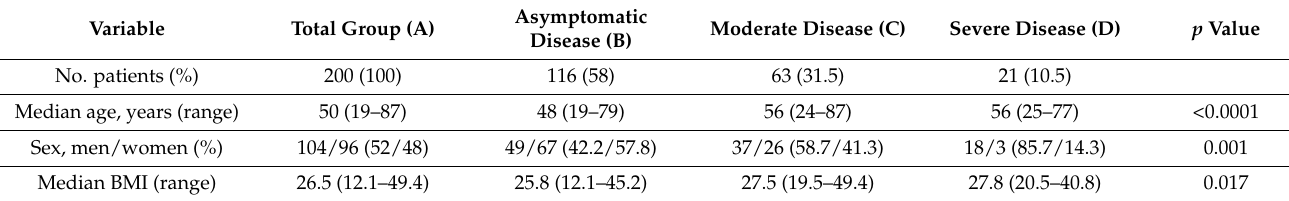
Table 1. Characteristics of the total patient cohort and the three subgroups: Patients were classified according to the most severe COVID-19 category according to the World Health Organization (WHO) classification, asymptomatic (B), moderate (C), severe disease (D). Comparison between the age and the body mass index (BMI) of the patients was performed with the Kruskal–Wallis test; comparison of sex distribution between groups was performed with the Chi-square test for trend. Statistical significance was set at the level of p <